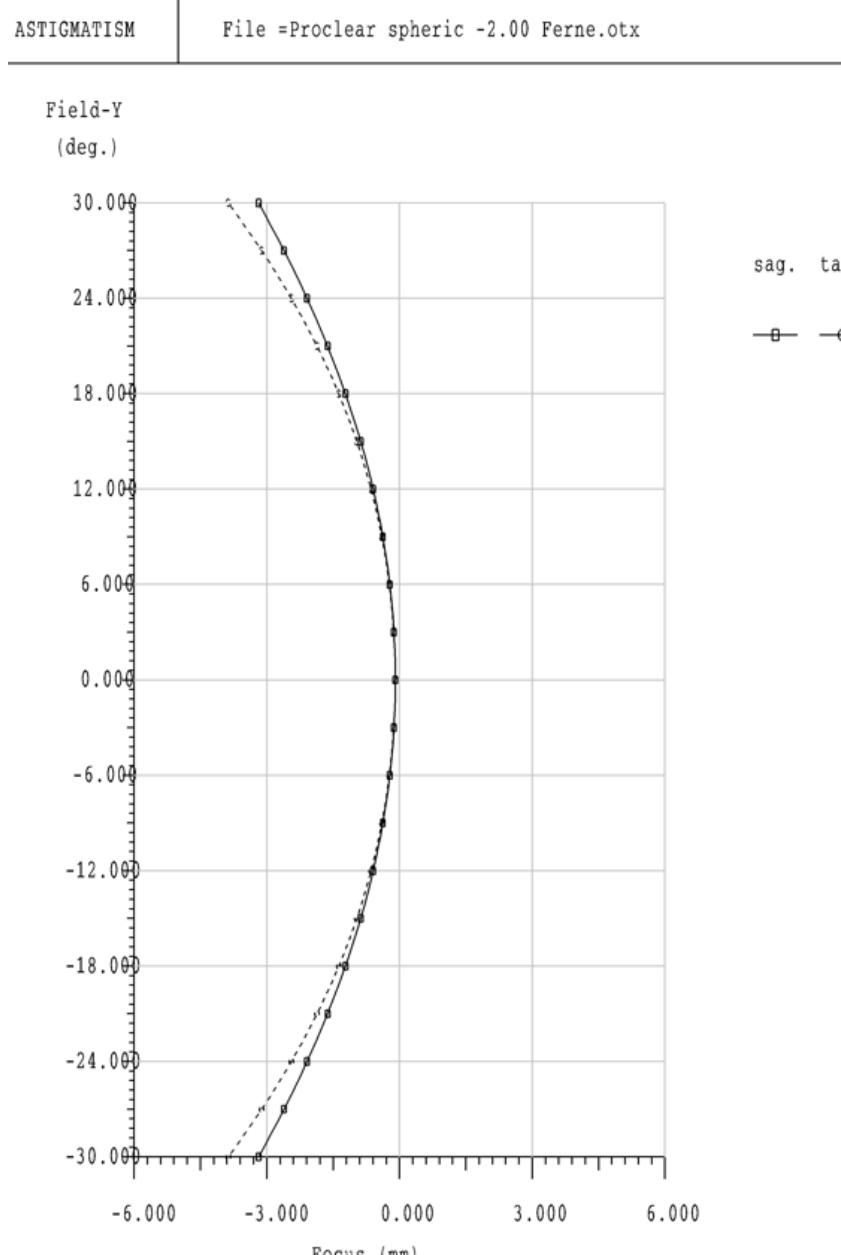
Figure 5. Peripheral refraction with Proclear monofocal correction − 2.00 D of myopia, viewing distance at infinity: sagittal and tangential focal lines. Within the central 12° is a plano-refraction; after the central 12° both focal lines become myopic relative to the center (Fovea).